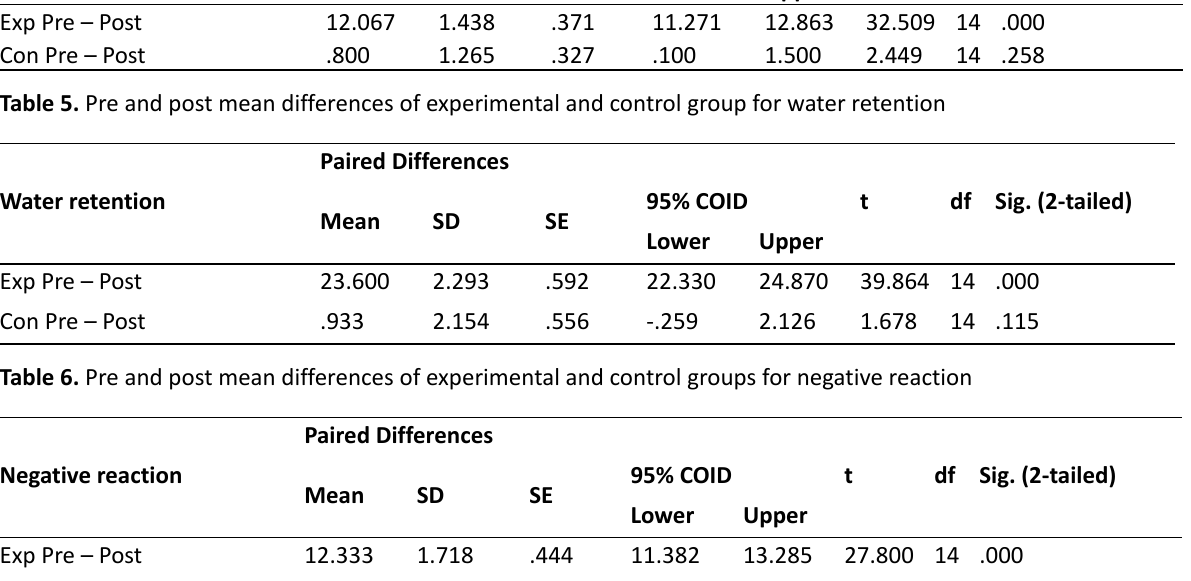
Autonomic reaction